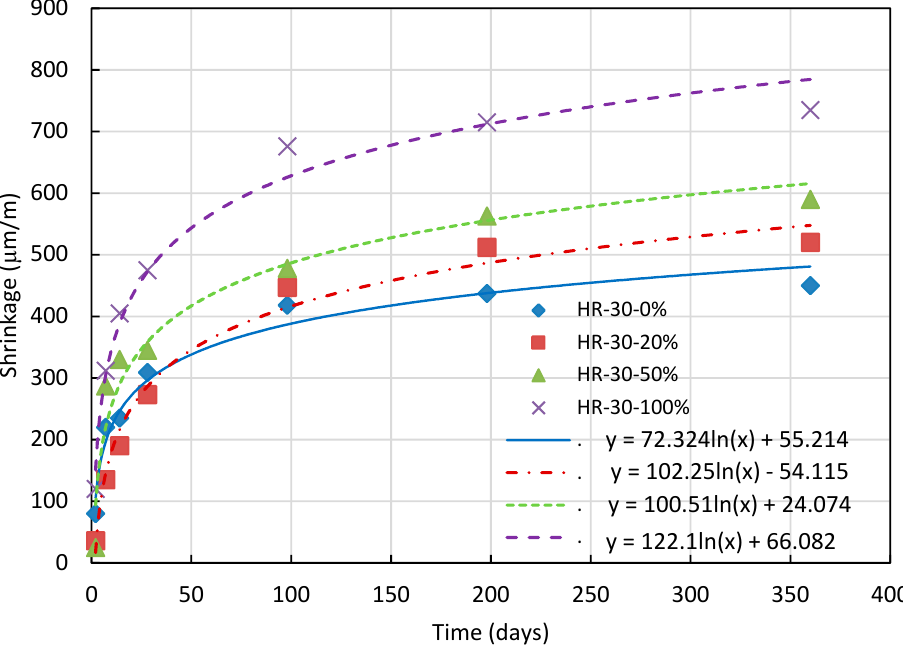
Figure 6. Evolution of the shrinkage vs. time of the HR-30 concrete.